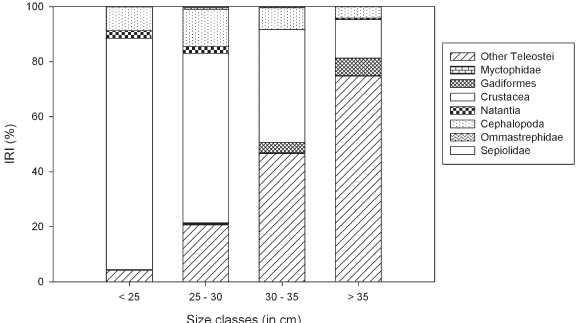
Fig . 4. – Index of relative importance (%IRI) of prey items in rela- tion to the size classes Etmopterus pusillus . Data from trawl gear only. Cephalopoda includes all unidentified cephalopods except for those from the Ommastrephidae and Sepiolidade families. Crustacea includes all unidentified crustaceans except for Natantia. (Number of specimens with TL ≤ 25 cm=96; 26-30 cm=94; 31-35 cm=56; and >35 cm=49).